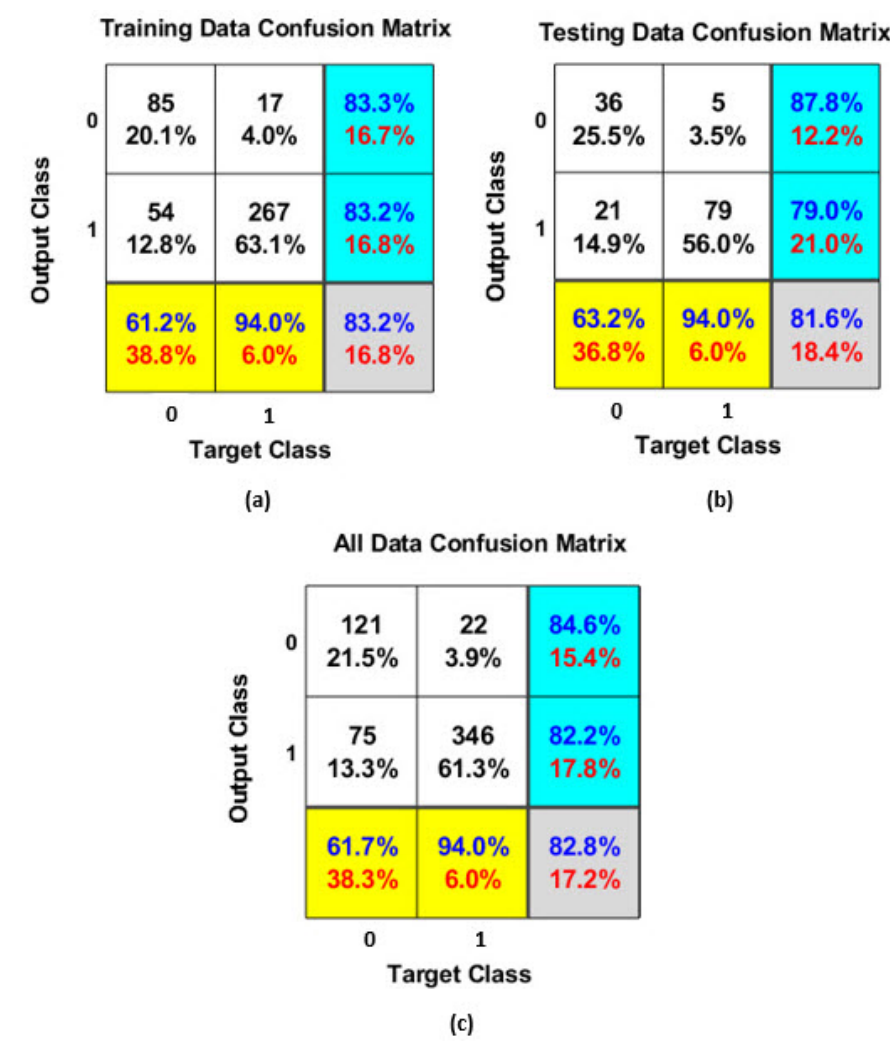
Figure 4. Confusion matrices of training data ( a ), testing data ( b ), and total data ( c ).